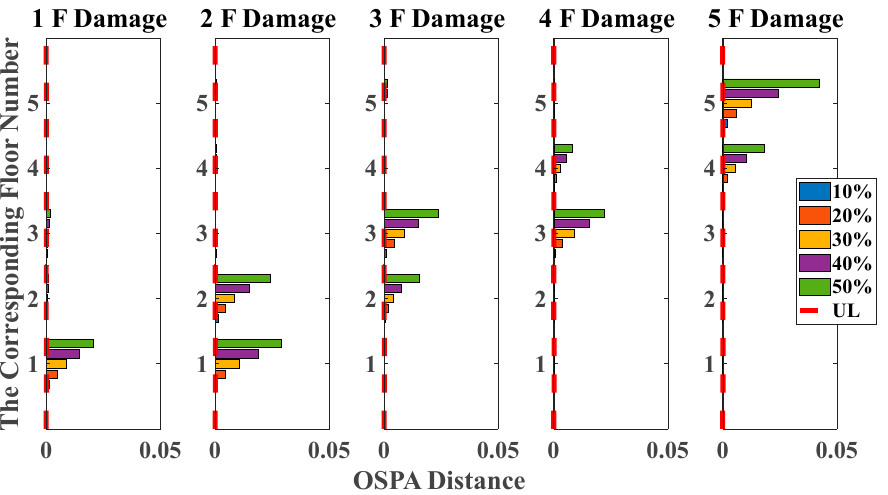
Figure 8. Damage detection results based on the OSPA distance (mutually correlated white noises inputs, 5% noise, autoregressive model, data length = 4000, AR order = 1, OSPA.p = 2).